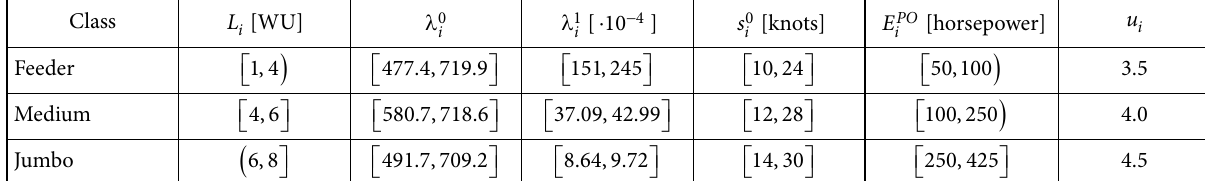
Table 3. Parameters of uniform distribution for three vessel